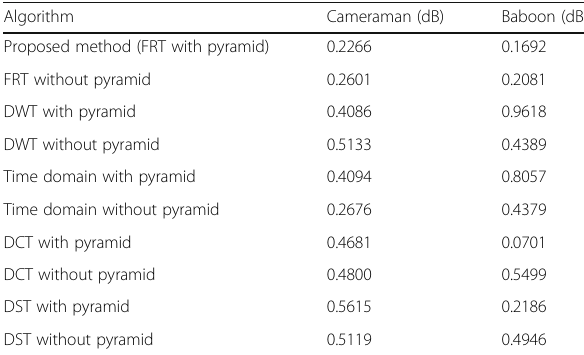
Table 3 RMSE of overall separation performances on image mixtures